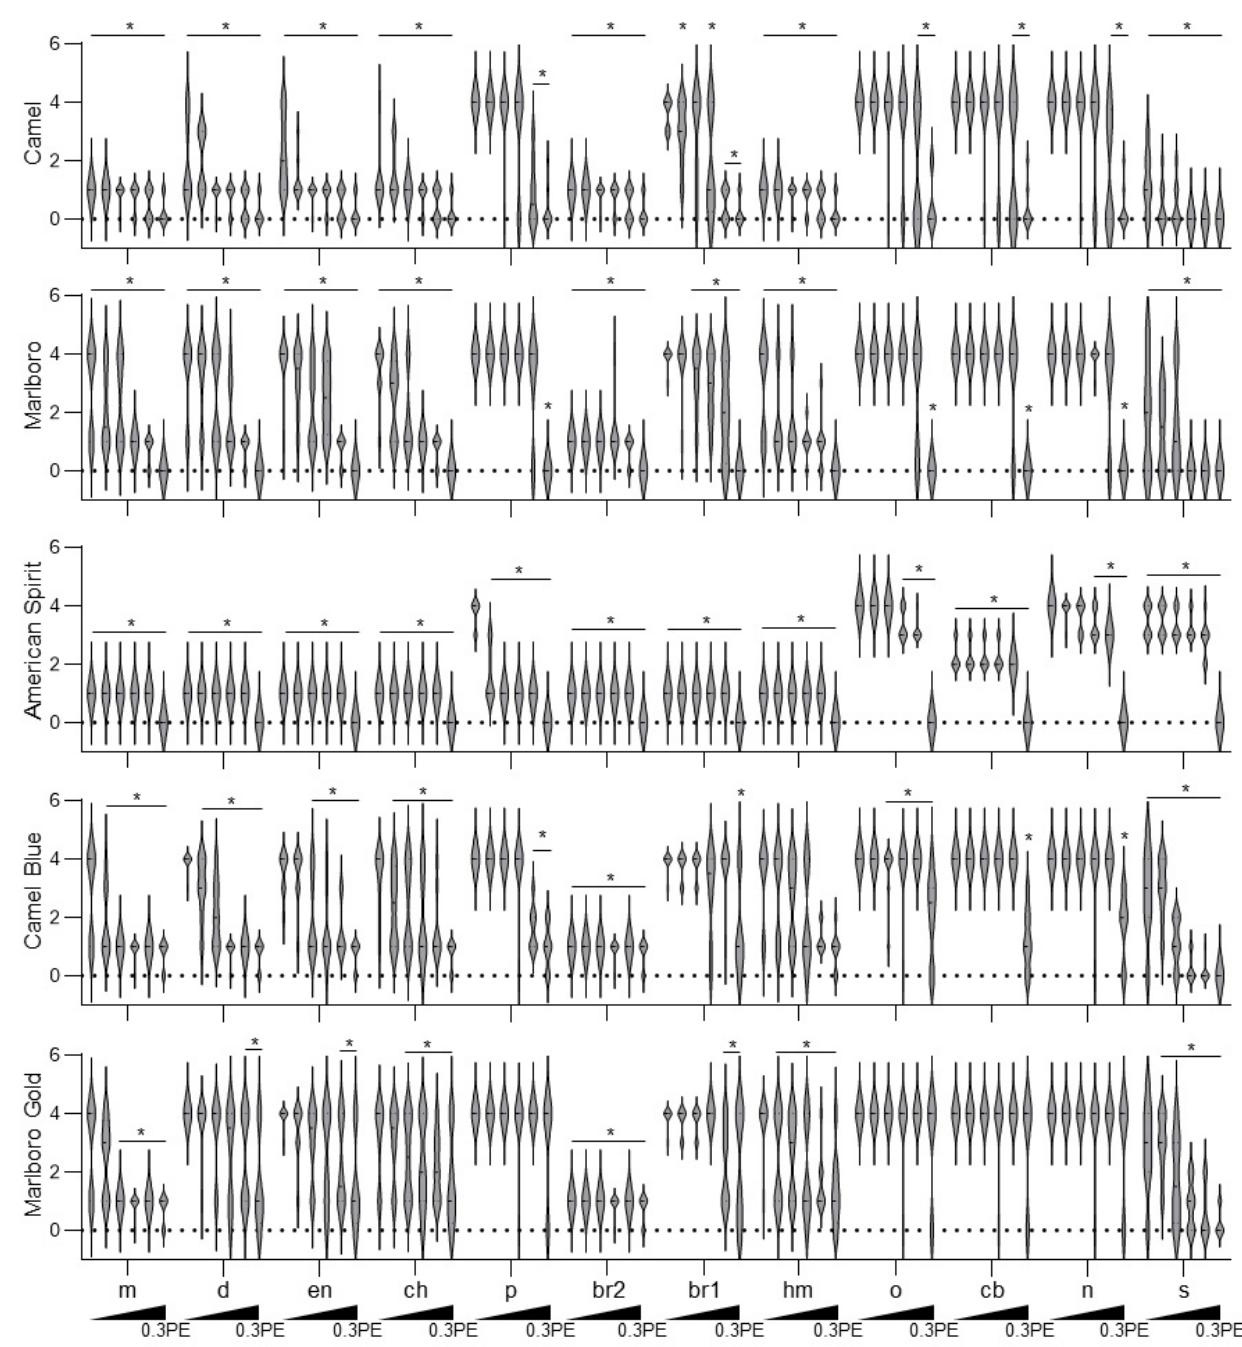
Figure 6. Quantitative morphometric scoring of bone mineralization defects in zebrafish larvae exposed to tobacco smoke extract. Embryos were dosed with tobacco smoke extracts at the indicated concentrations, starting at 5 hpf. Quantitative scoring was performed from images of 6 dpf-old Alizarin-Red-S-stained larvae. Bones that developed to the natural size and possessed a similar staining intensity to that of the control were given a score of 4. One point was subtracted for misshapen or dim bones, resulting in a minimum score of 2 points for a dim and deformed yet still present bone. Any bone that did not appear was given a score of 1. * p < 0.05, one-way ANOVA with a Dunnett’s post hoc test to correct for multiple comparisons. Br1, branchiostegal ray 1; p, parasphenoid; br2, branchiostegal ray 2; hm, hyomandibular; o, opercle; cb, ceratobranchial 5; n, notochord; s, spinal calcification.